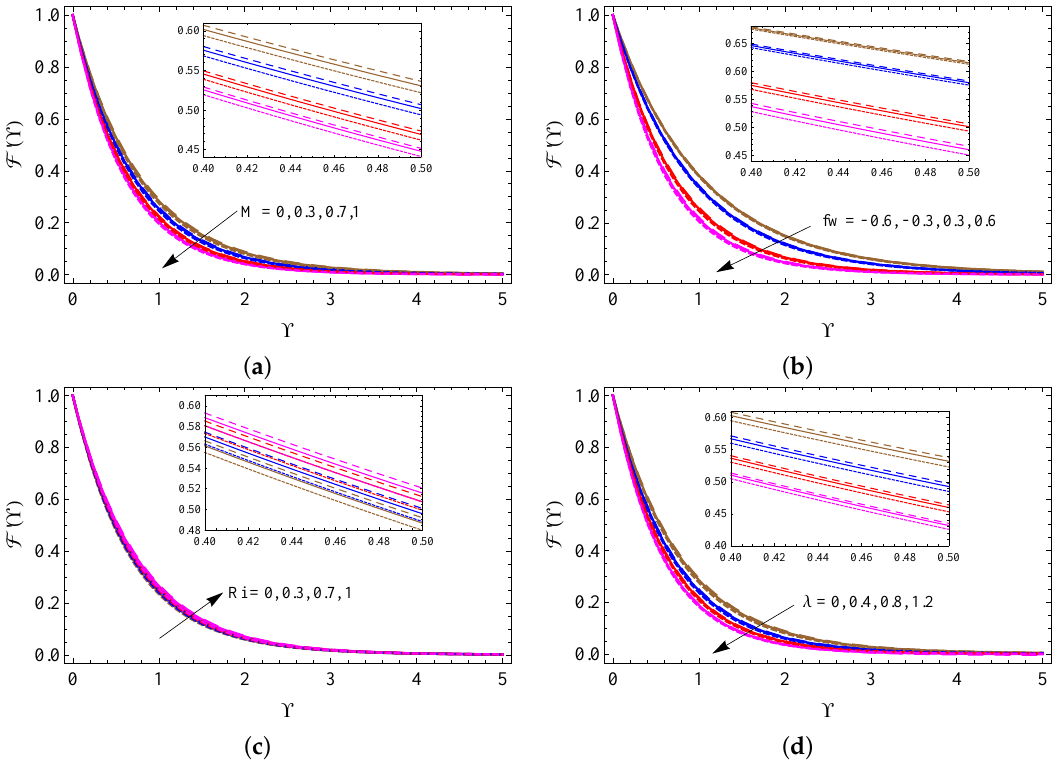
Figure 4. The contrast of F (cid:48) ( Υ ) against M ( a ), fw ( b ), Ri ( c ) and λ ( d ) for SWCNTs (solid line), MWCNTs (dashed line) and Al 2 O 3 nanofluid (dotted